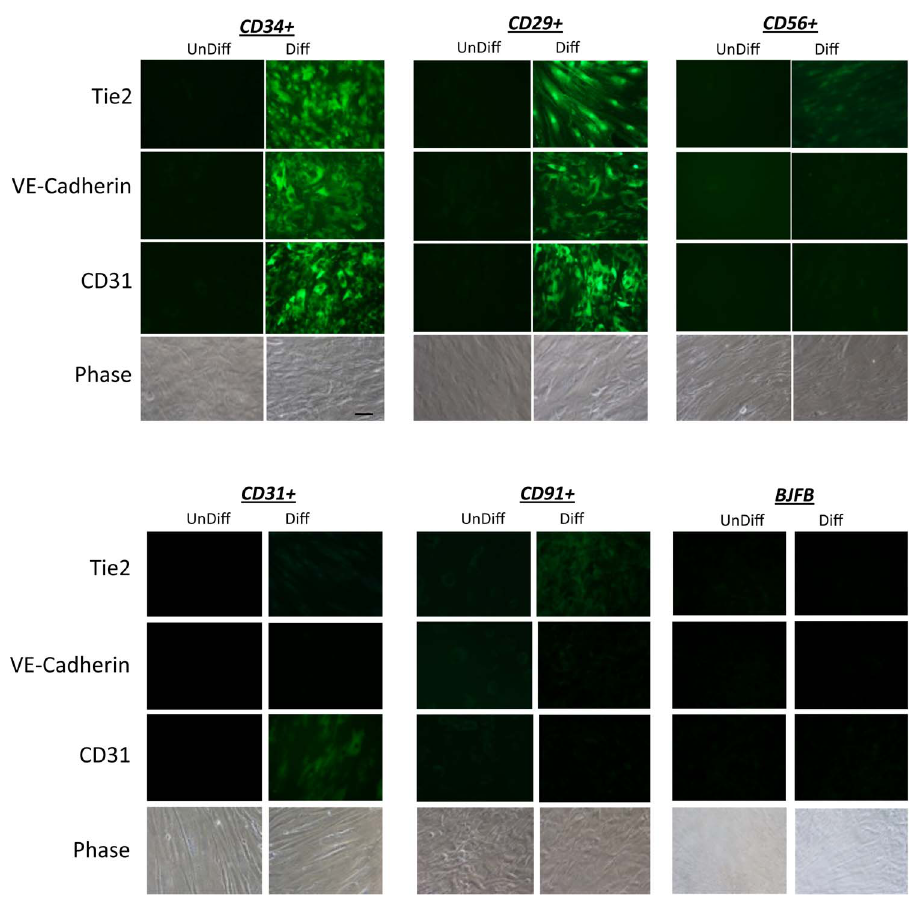
Fig. 9. Endothelial cell differentiation of CD29 + and CD34 + cells. Flourescent-conjugated antibodies to CD29, CD31, CD34, CD56 and CD91 were used to separately sort and subculture cells form collagenase 2 digested human muscle. The cells were cultured to confluence then were cultured for an additional two weeks in either vascular endothelial cell differentiation media (VEM) or regular growth media (GM). The cultures were fixed and processed for immunofluorescence microscopy using antibodies to VE-cadherin, Tie2 and CD31. Also shown is a representative phase contrast image of each cell type. Scale bar 5 50 m m.